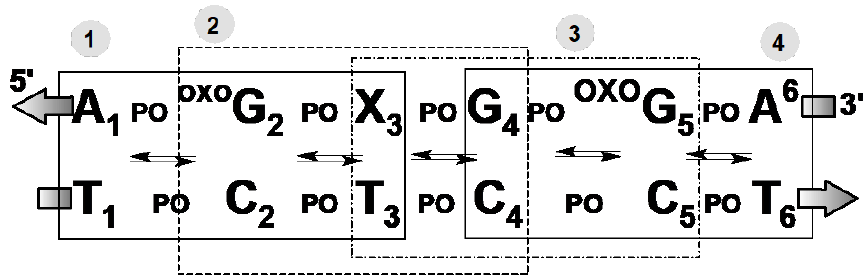
Figure 3. Graphical representation of ds -oligonucleotides divided into four trimes (indicated by dashed squares): oxo dG 2,4 DNA (X = dA); RcdA oxo dG 2,4 DNA; (X = (5’ R )-cdA); ScdA oxo dG 2,4 DNA (X = (5’ S )-cdA).